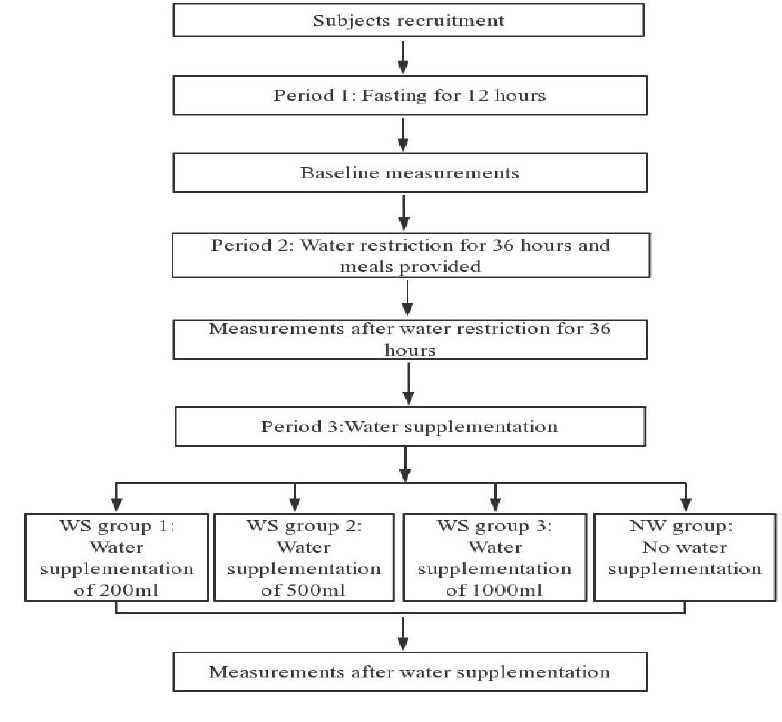
Figure 1. Study design. Table 1. All items from the World Health Organization Trial Registration Data Set (SPIRIT checklist, item 2b).